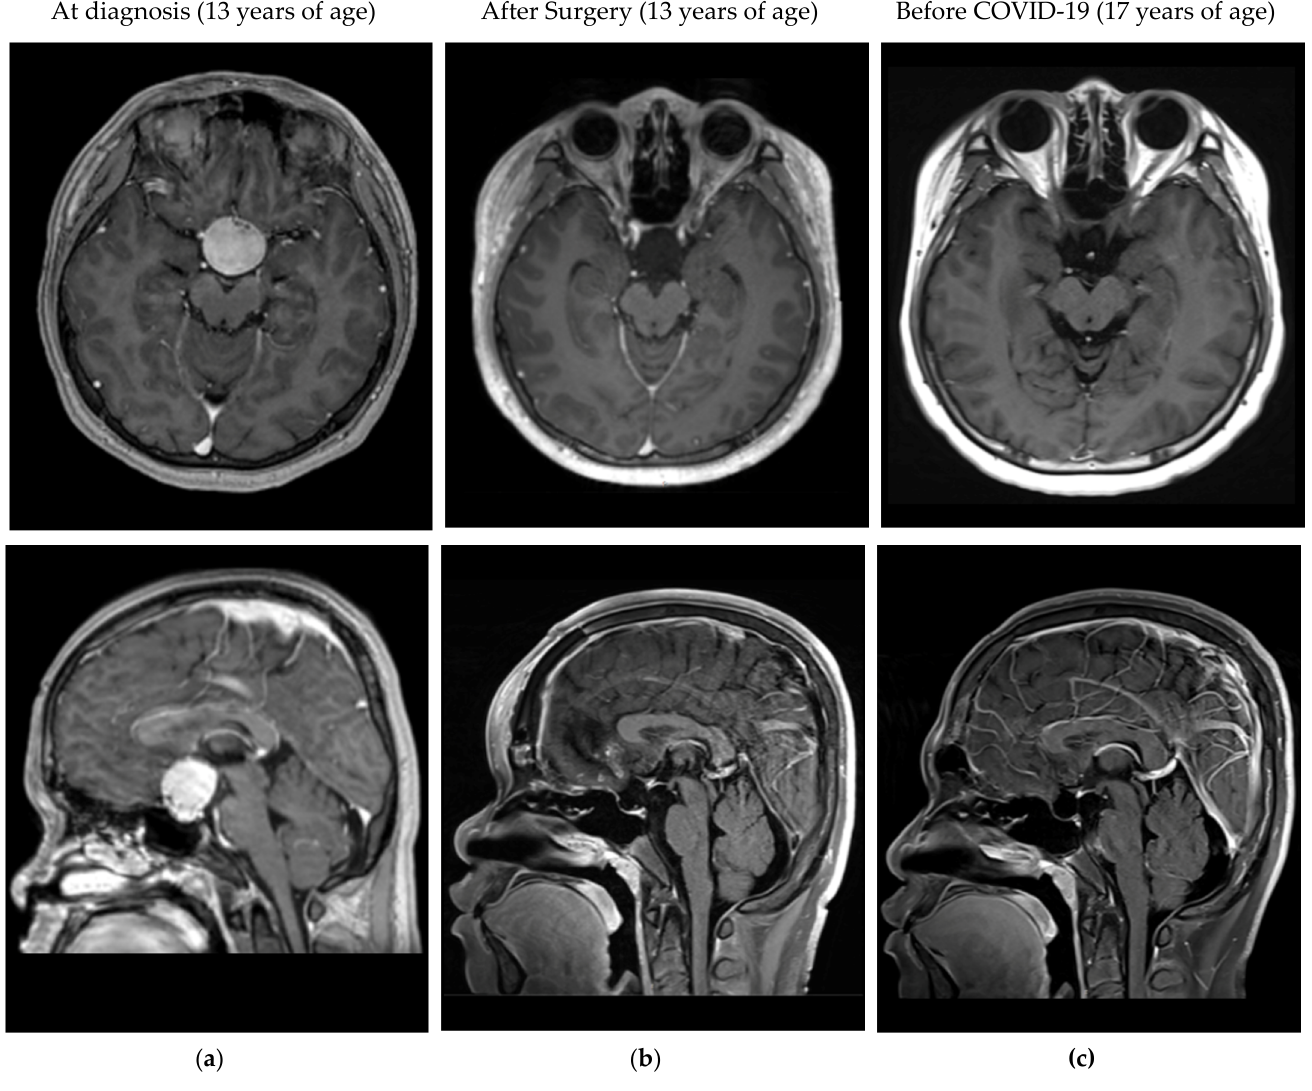
Figure 1. Neuroimaging of the patient’s craniopharyngioma before and after surgical treatment. ( a ) At diagnosis: Magnetic resonance imaging (MRI) at the age of 13 years showed a round, well-circumscribed, vividly enhanced, suprasellar tumor measured 27 × 28 × 29 mm in size. ( b ) After surgery: MRI on the 7th postoperative day showed a gross total resection. ( c ) Most recent follow-up: MRI at 3 months before onset of COVID-19 showed no signs of tumor progression. All images were T1-weighed magnetic resonance imaging with contrast enhancement. Table 1. Laboratory data at